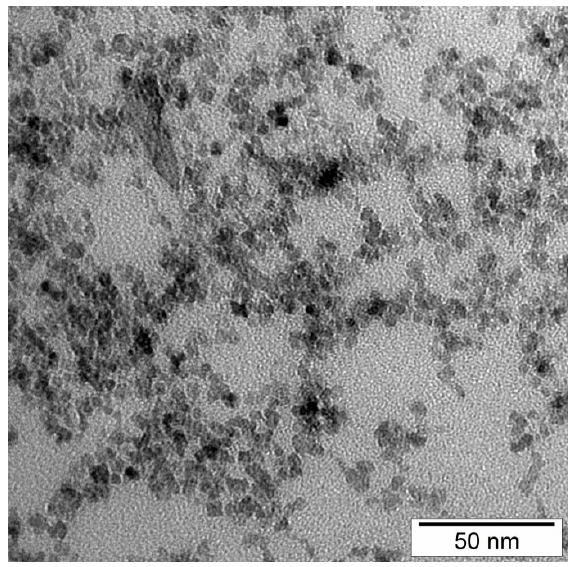
Figure 2. Transmission electron microscopy (TEM) of superparamagnetic iron oxide nanoparticles.